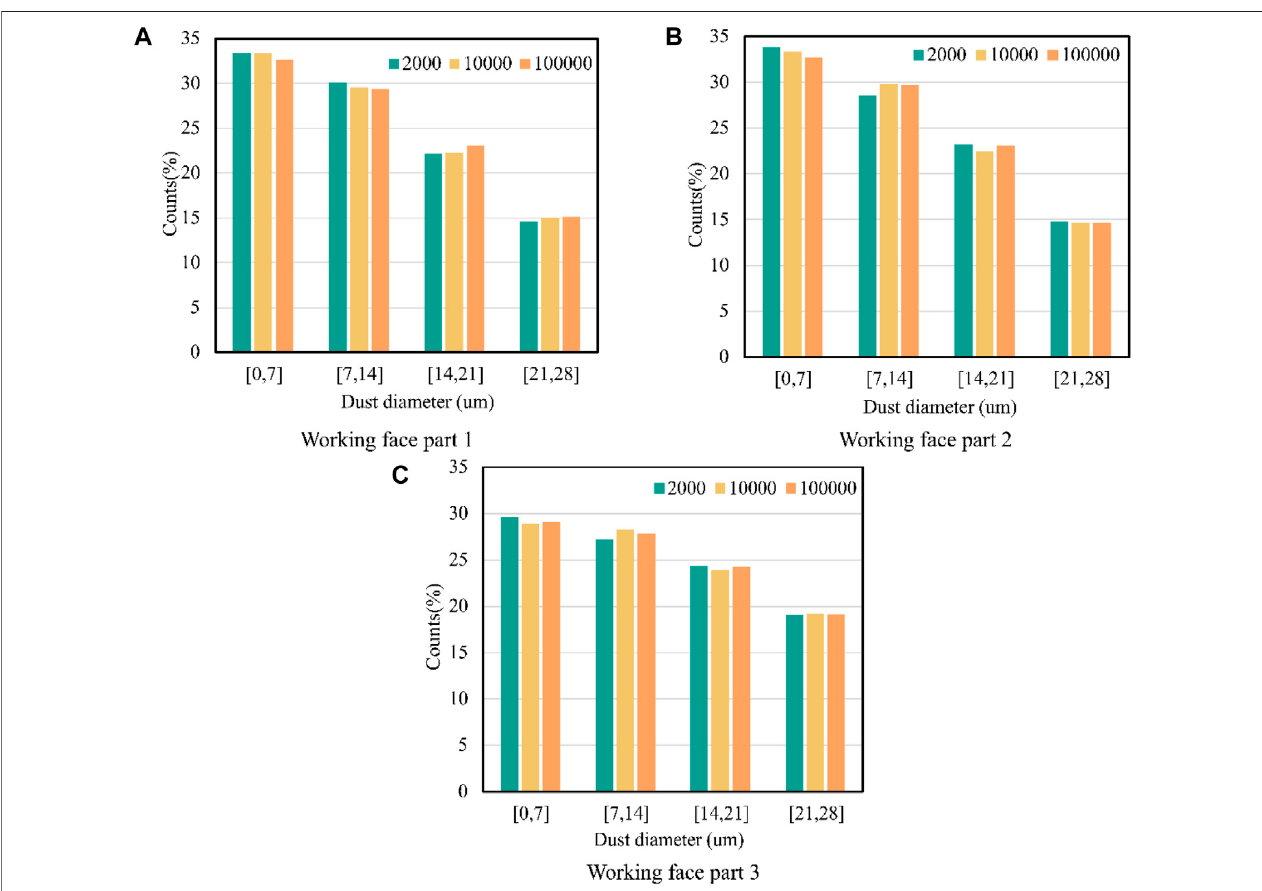
FIGURE 7 | Different particle size rates: (A) Working face part 1; (B) Working face part 2; (C) Working face part 3.